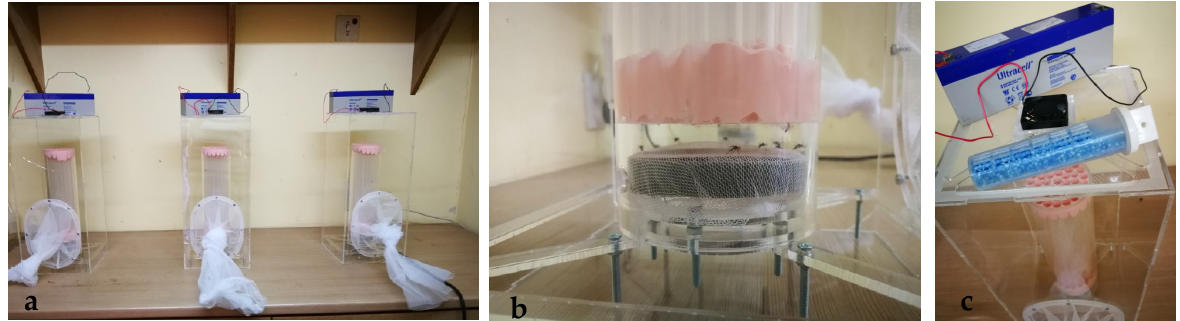
Figure 1. The flight capicity testing: ( a ) the simultaneous use of three IAEA flight devices. ( b ) The males introduced into the device cylinder. ( c ) The BG lure, energy source, and fan at the top of the device.